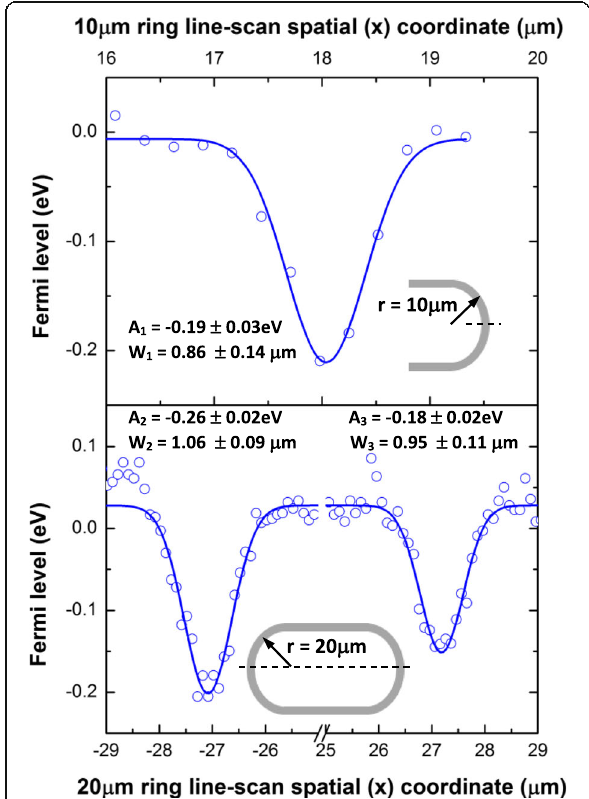
Fig. 4 Graphene Fermi level determined (from √ A G A spatial coordinate along line scans for (top) 10- μ m- and (bottom) 20- μ m-radius MRR devices (note the break in the bottom x -axis).